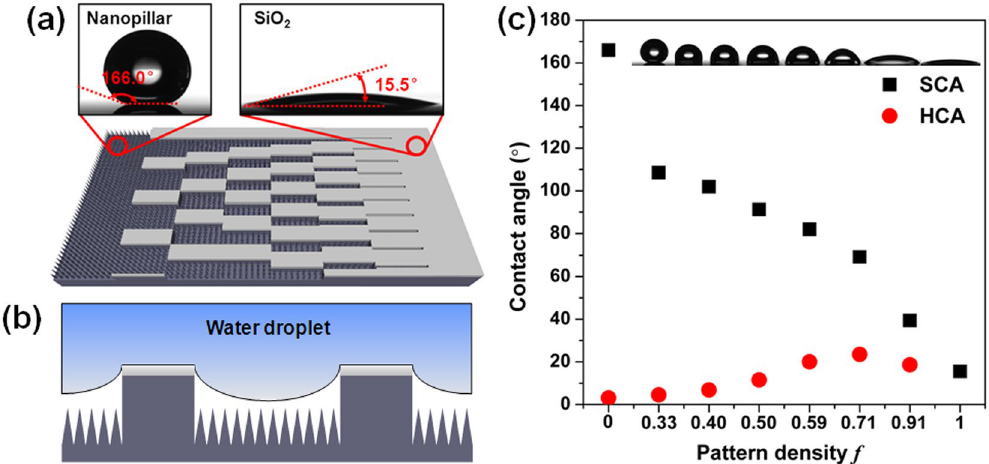
Figure 2. Surface design and wettability characterization. The size of all the SiO 2 stripe is 1 mm × 90 μ m × 2 μ m. ( a ) Top view schematic of the gradient surface. From left to right, the pattern densities are 0, 0.33, 0.40, 0.50, 0.59, 0.71, 0.91, 1, and the space between SiO 2 stripes are 180 μ m, 135 μ m, 90 μ m, 63 μ m, 36 μ m, 9 μ m, 0 μ m, respectively. ( b ) Undercut structure of solid-liquid contact region. ( c ) The static contact angle (SCA) and hysteresis contact angle (HCA) of water droplet on each region of the gradient